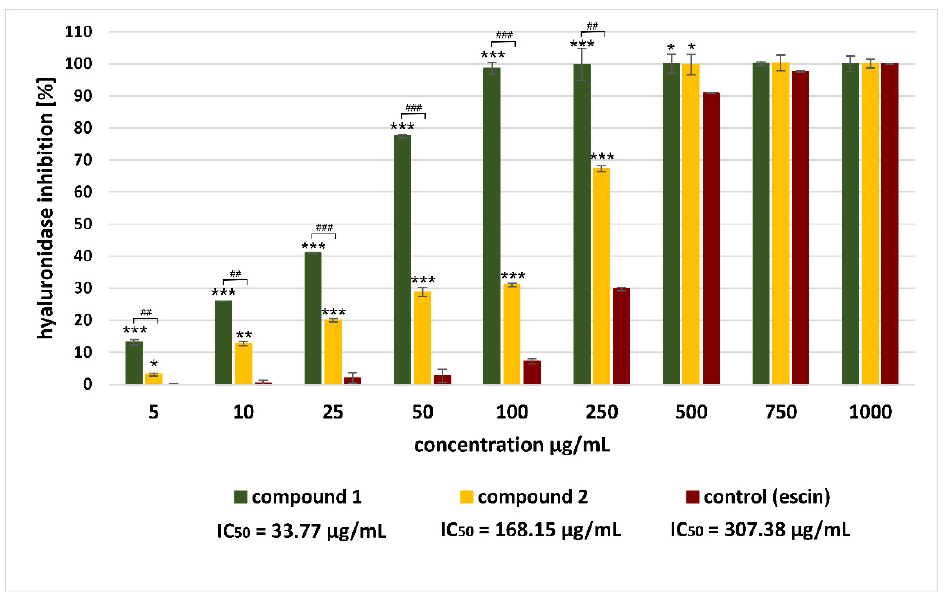
Figure 2. Antihyaluronidase activity of saponins (compound 1 and compound 2 ) isolated from methanolic extract of Atriplex sagittata Borkh flowers. The results are presented as the mean± standard deviation (SD) calculated from six independent experiments. Values significantly different from the control (escin) are indicated by * for p < 0.05; ** p < 0.01, *** p < 0.001; Results for compound 1 significantly different vs. compound 2 are indicated by:, ## p < 0.01, ### p < 0.001.